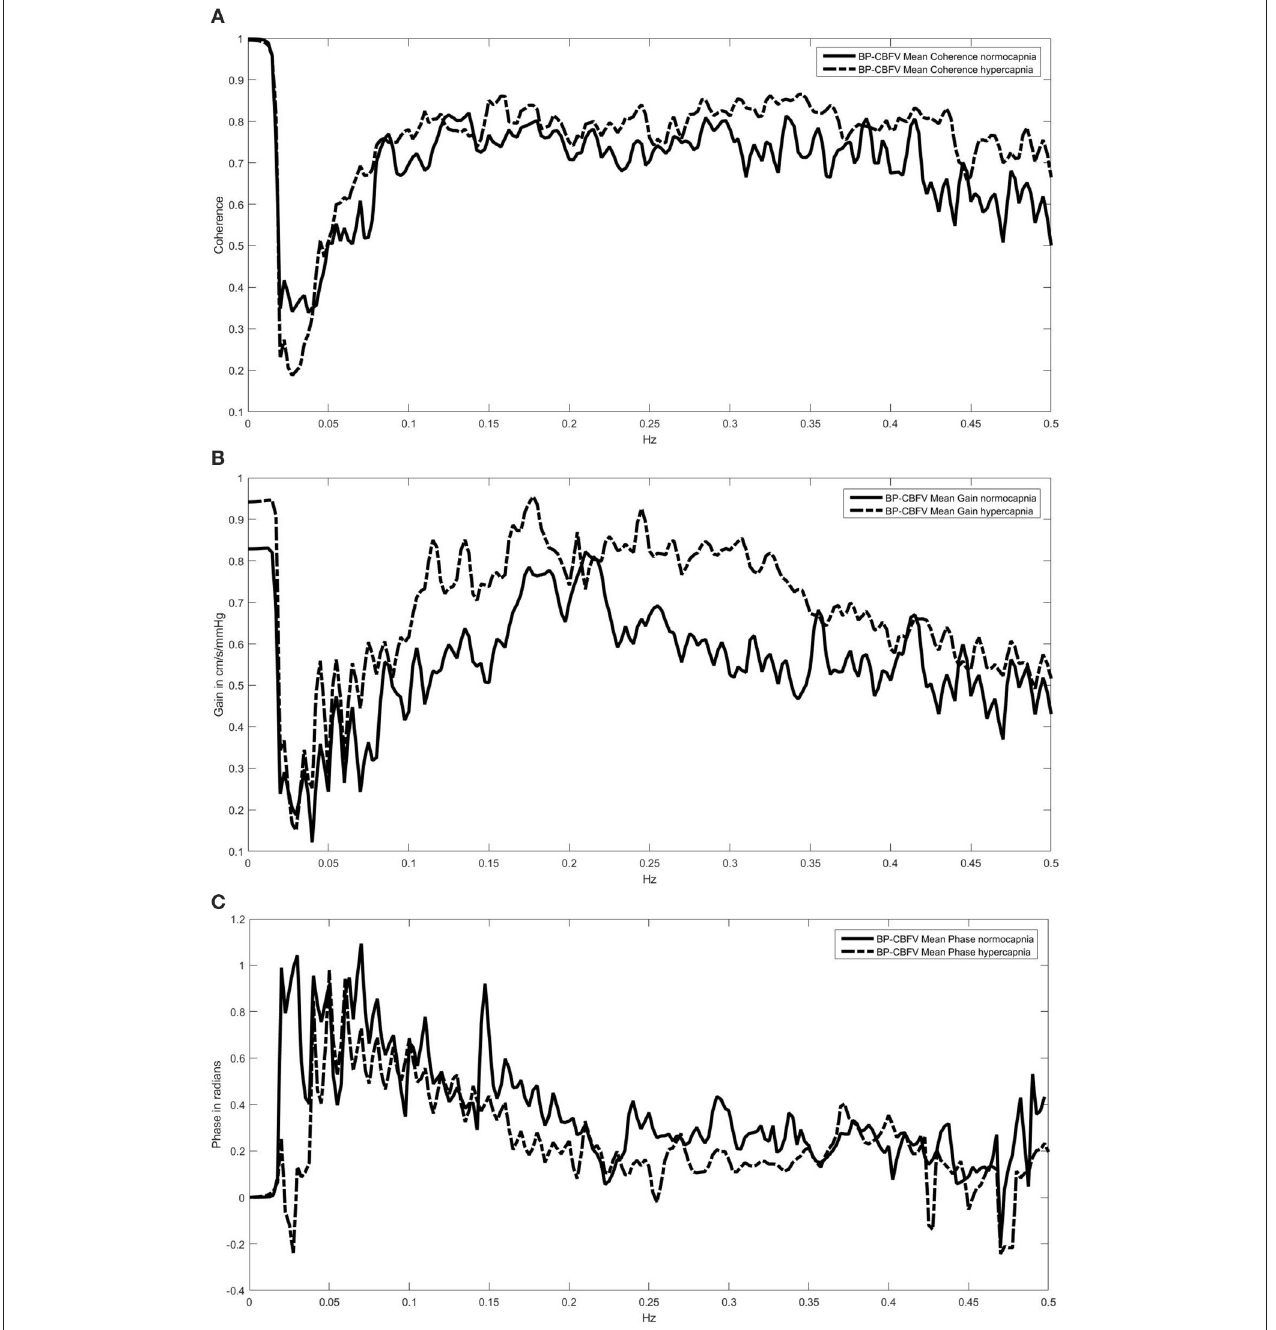
FIGURE 1 | Coherence (A) and transfer function spectra (gain B; phase shift C) of the blood pressure (BP)—cerebral blood flow velocity (CBFV) system under normo- and hypercapnia. The high coherence indicates a highly stable phase relationship over the whole frequency range. For convience, we show in all three parts the means only and did not include the SD range of both curves.